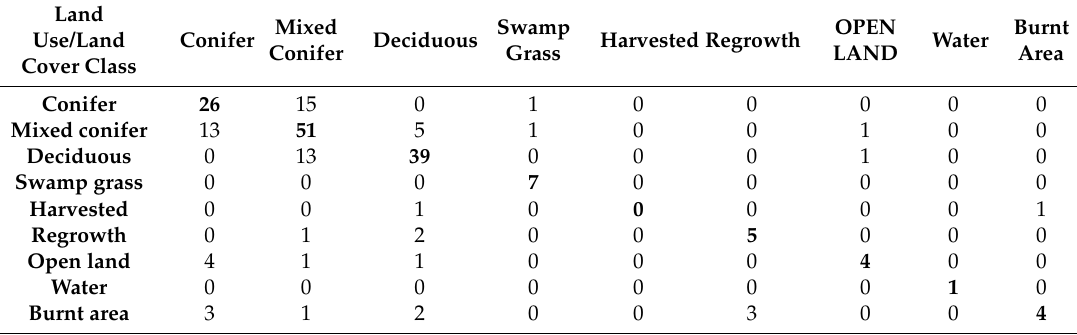
Table 8. Land use/land cover error matrix for maximum likelihood classification. Reference values in horizontal and mapped values in